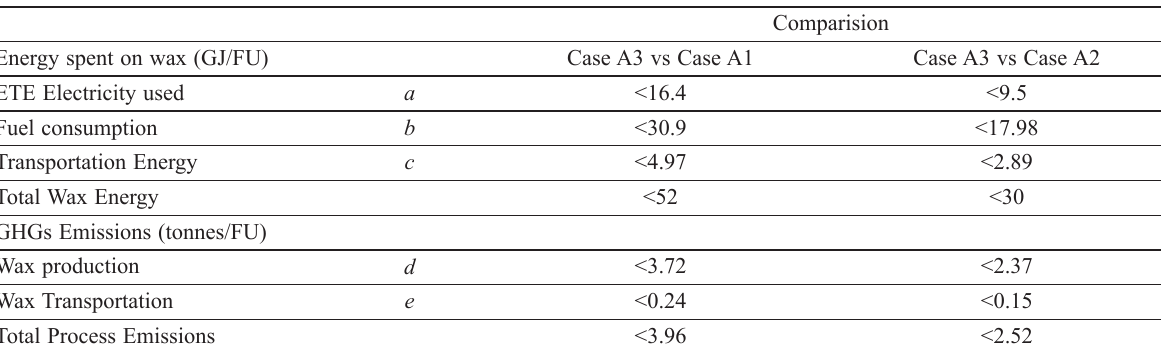
Table 4. Beneficial bitumen modification boundaries w.r.t. energy and emissions allocation for Case Study A